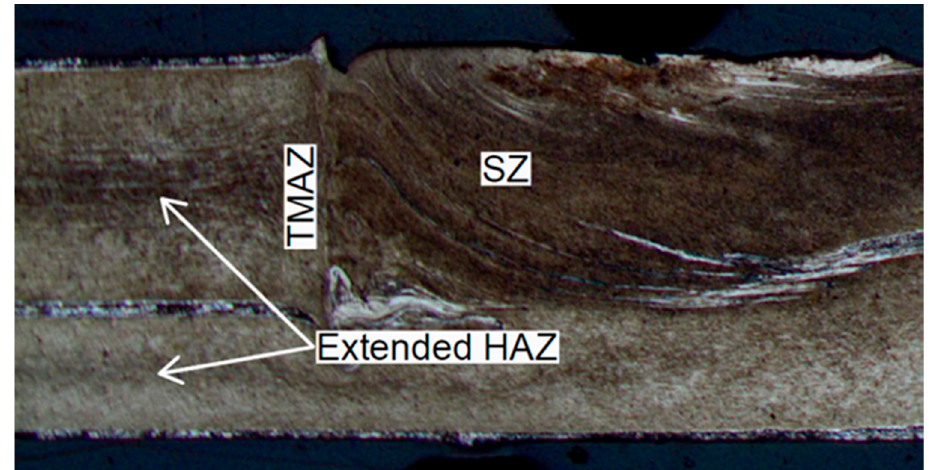
Figure 14. Macrostructure of the weld with extender HAZ (experiment E1).